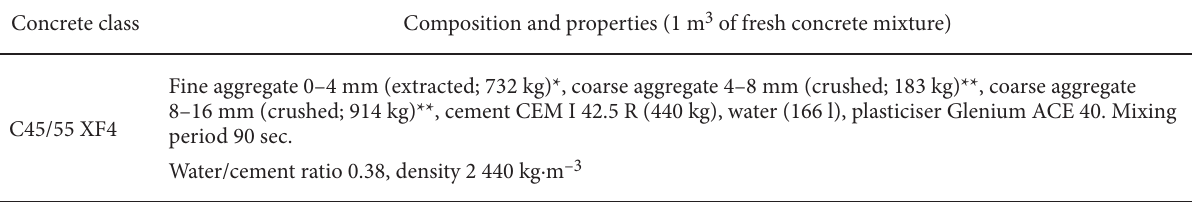
Table 1. Composition of tested concrete samples Concrete class Composition and properties (1 m 3 of fresh concrete mixture)